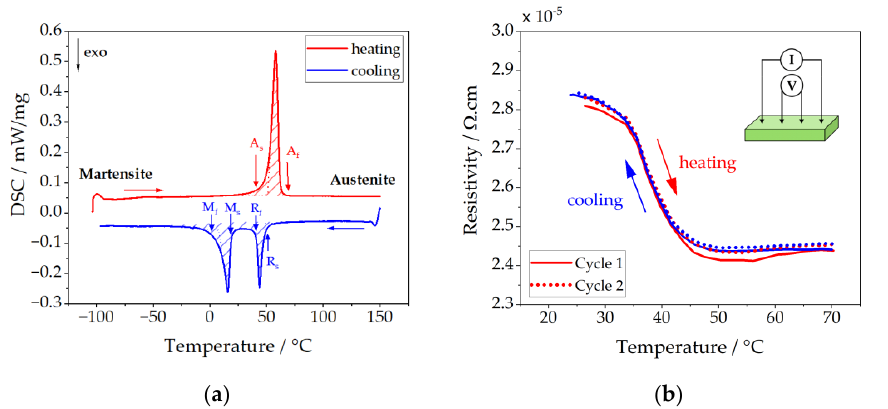
Figure 1. ( a ) Differential scanning calorimetry measurement of a cold-rolled NiTi foil of 20 µm thick- ness; ( b ) four-point-probe electrical resistivity measurement in the temperature regime of actuation above room temperature.